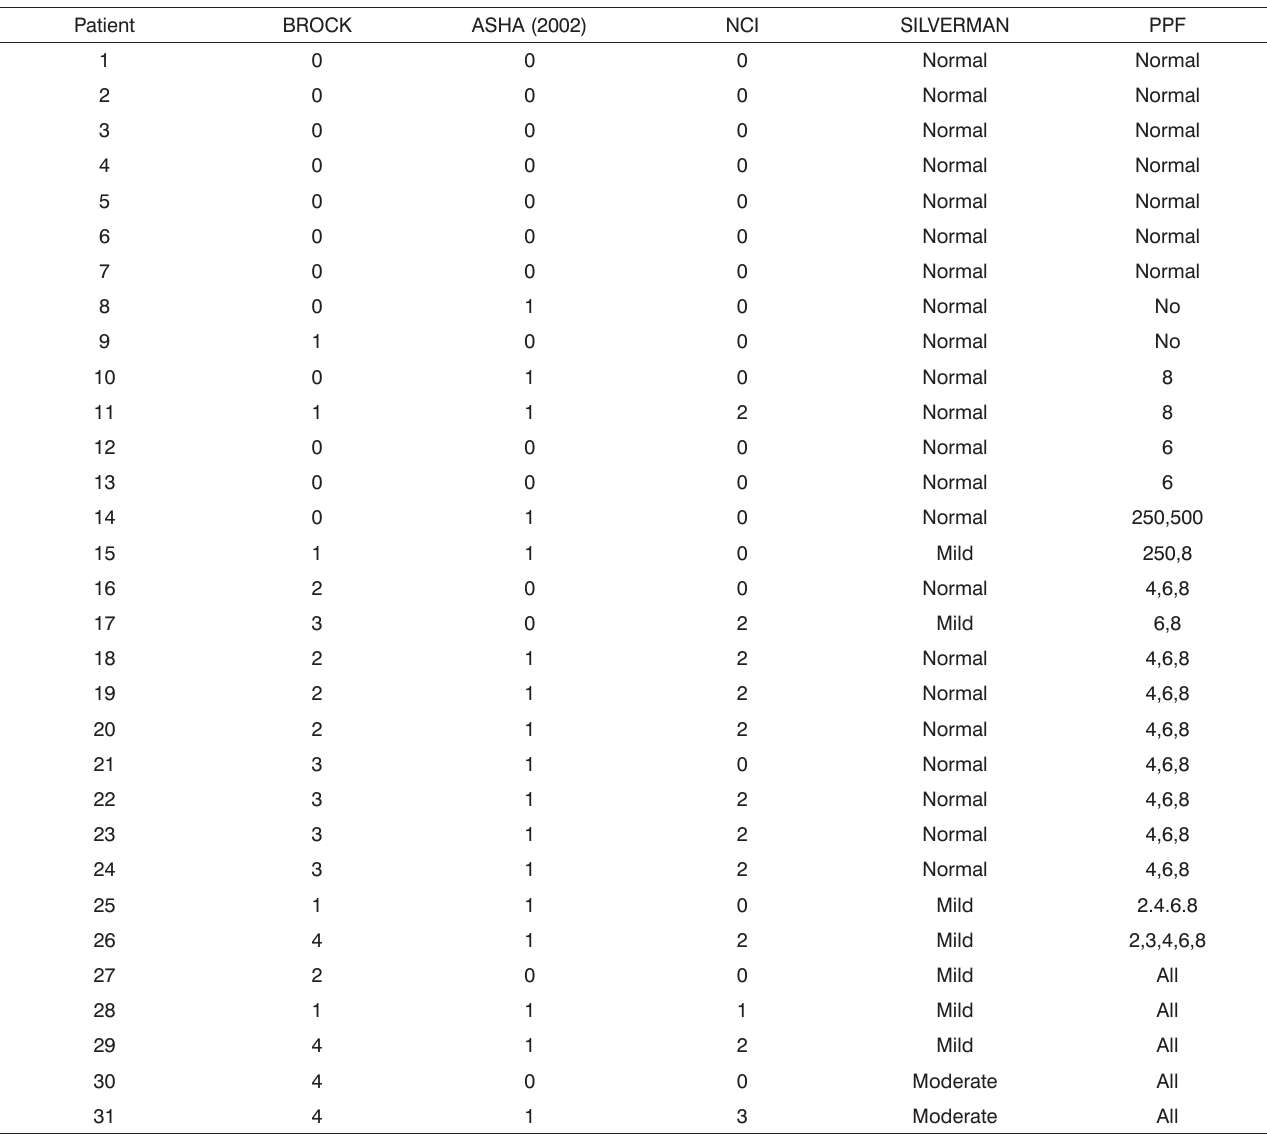
Table 1. Distribution of hearing loss classifications in the study population according to the criteria